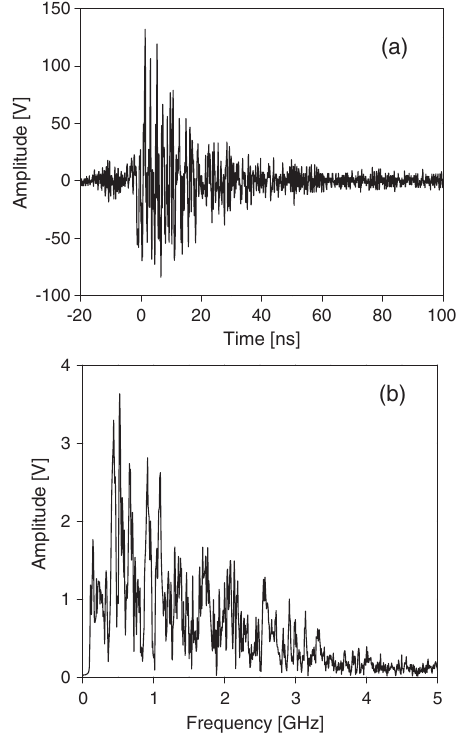
FIG. 3. Amplitude of the EMP signal measured with a B probe placed 26 cm from the laser-target interaction point (a) and corresponding frequency spectrum (b).